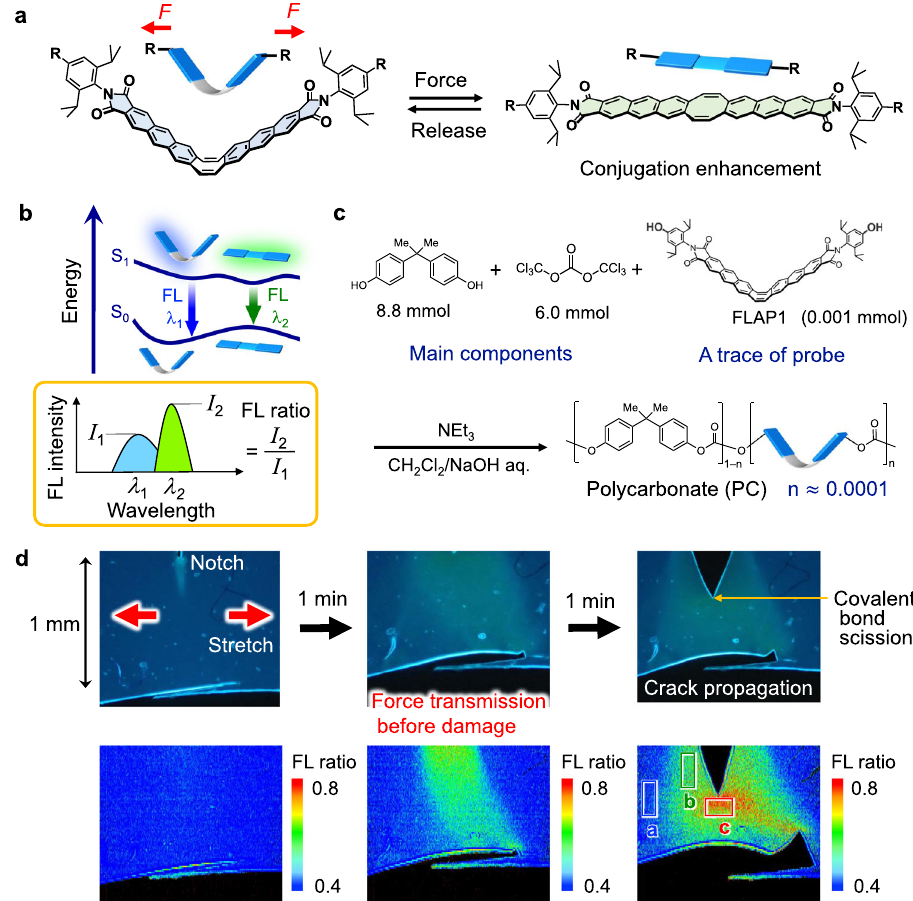
Fig. 2 Conformationally fl exible force probe and the application to ratiometric fl uorescence imaging. a Flapping molecular force probe (FLAP) that enables b quantitative ratiometric analysis based on dual fl uorescence (FL). c Preparation of polycarbonate (PC) from bisphenol A and triphosgene chemically doped with trace amounts of FLAP1 (0.05 wt%). d FL microscopy images of the notched PC specimen under 365-nm UV irradiation. Force transmission induced before crack propagation by tensile testing (strain rate of 2.0 × 10 − 3 s − 1 ) (top). Corresponding two-dimensional ratiometric FL images (FL 525 /FL 470 ) obtained by a hyperspectral camera (bottom). In the last image, an unstretched region (A), a backward region of the crack (B), and the crack tip front (C) are